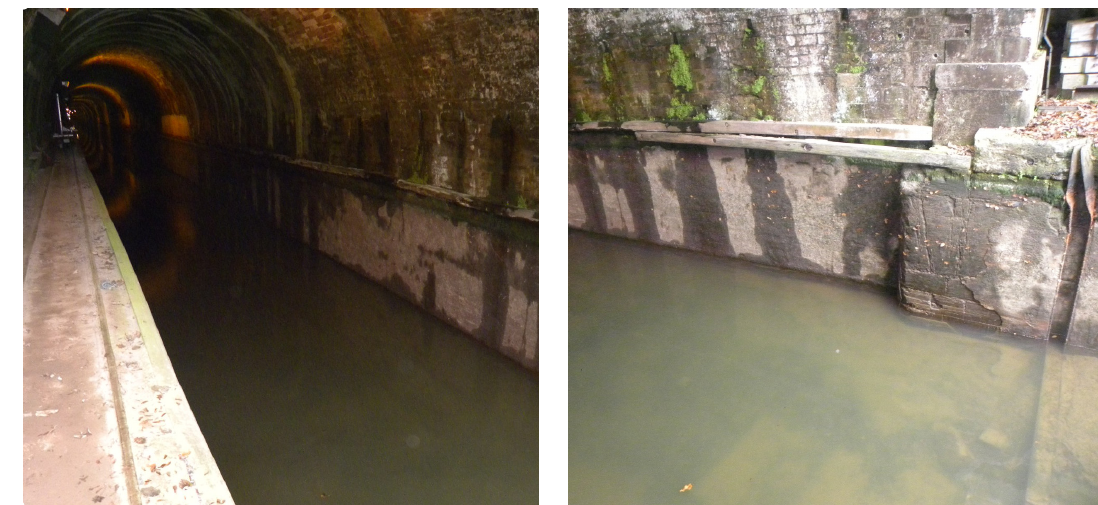
Figure 3. Entrance of Arzviller’s tunnel during its emptying in